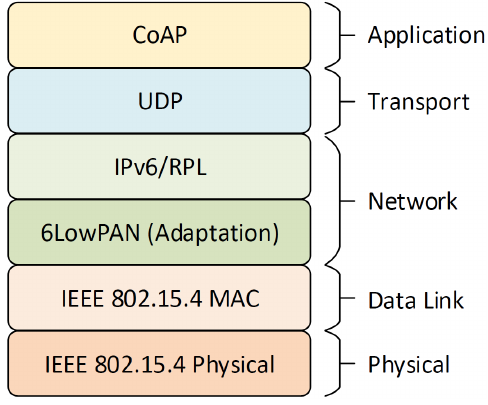
Figure 7. Protocol